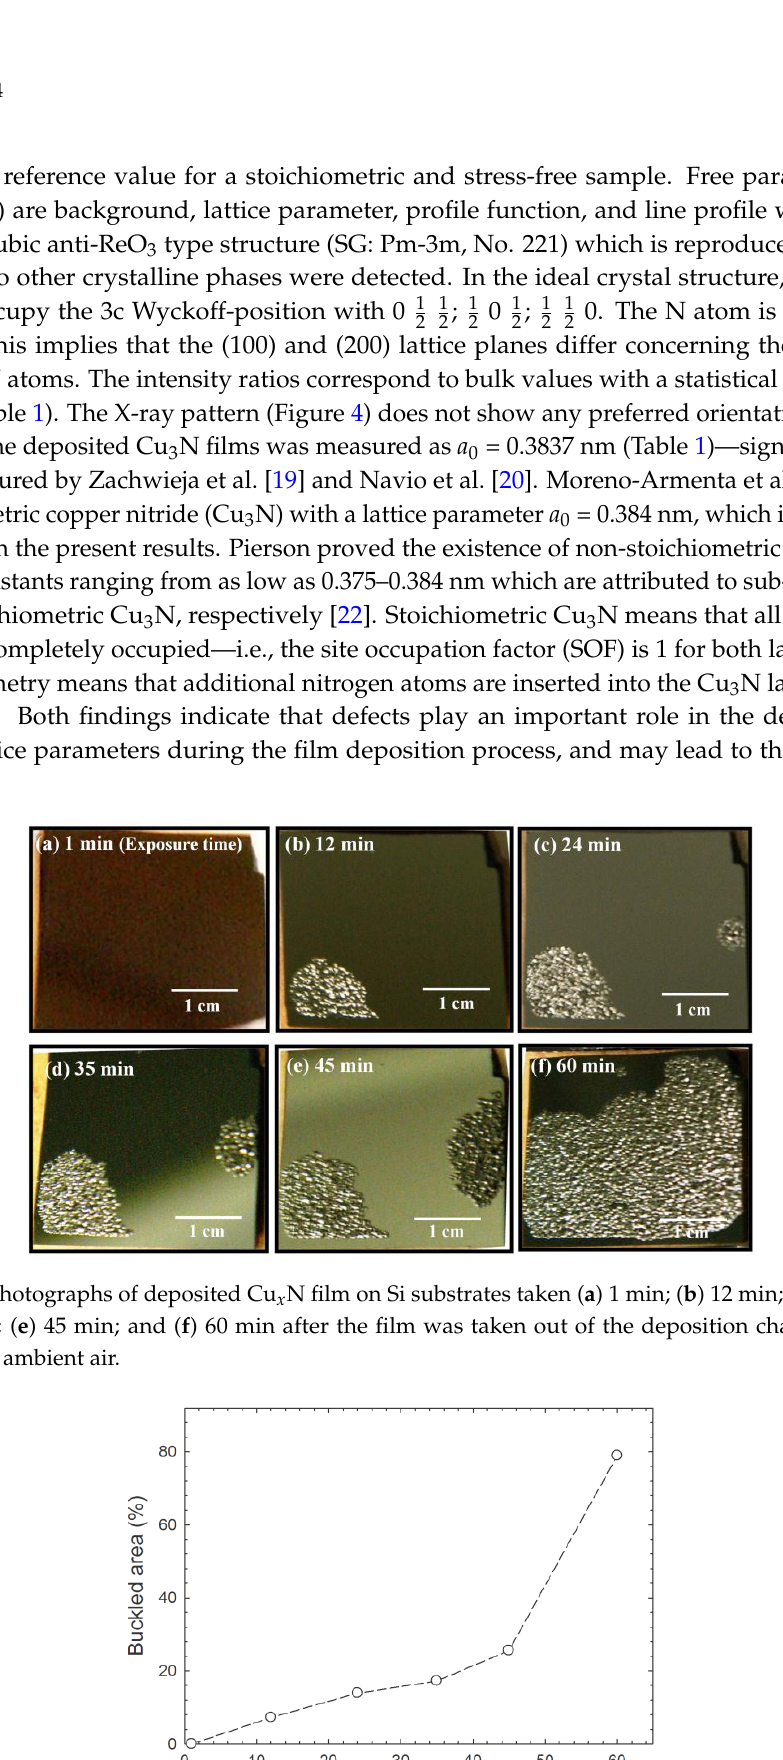
Figure 2. Buckled film area (in percent of the total area) versus exposure time.